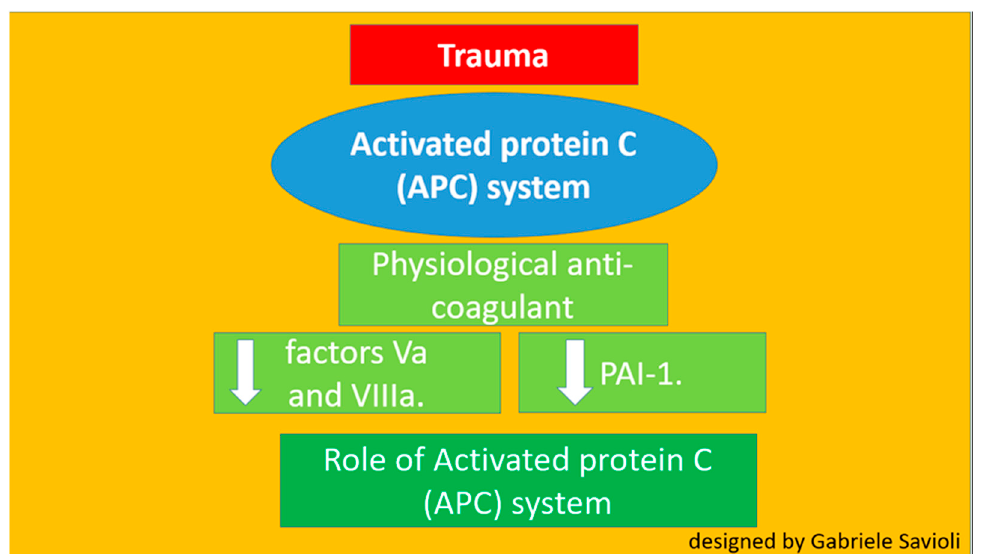
Figure 3. Role of protein C.